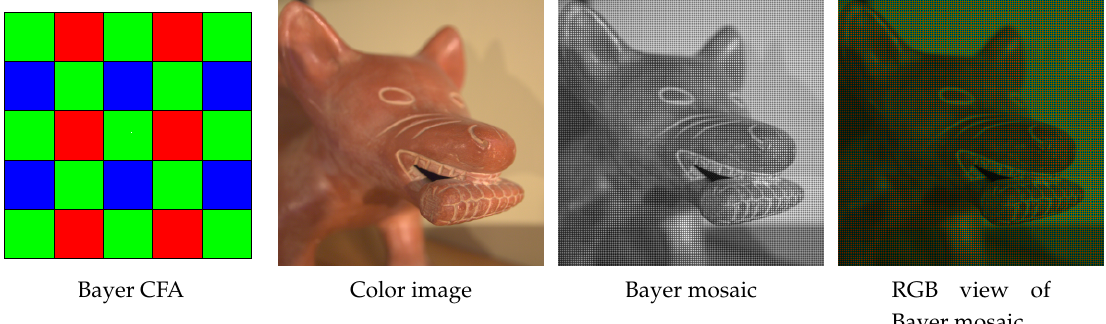
Figure 1. Bayer color filter array (CFA)